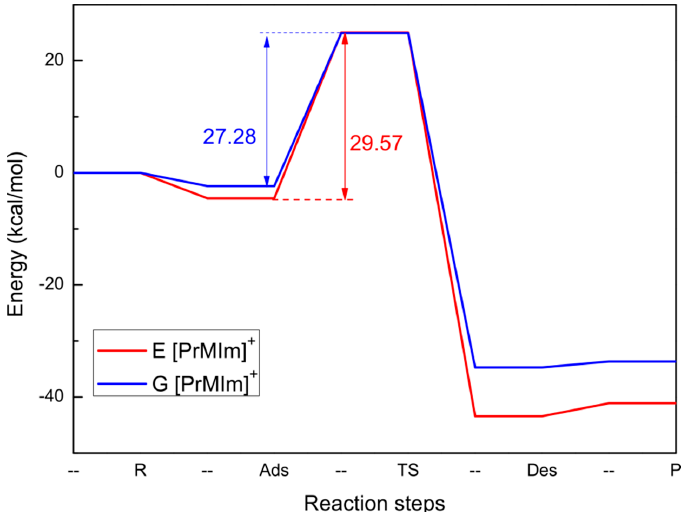
Figure 11. Reaction path of acetylene hydrochlorination, using [PrMIm]Cl alone as the catalyst. Shown here is a process participated by the [PrMIm] + cation. The blue, light grey, dark grey, and green balls represent N, H, C, and Cl atoms, respectively.